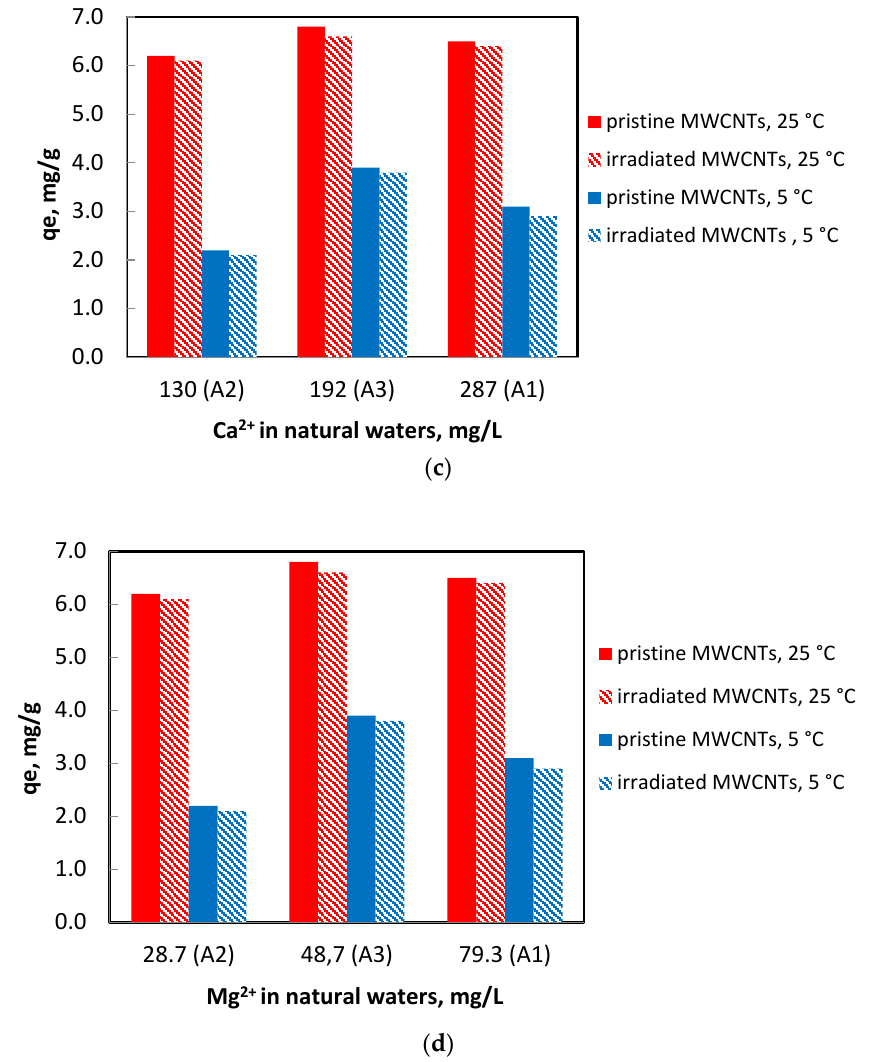
Figure 5. Influence of chemical ionic species (cations) present in tested waters on the adsorption capacity of TCC on MWCNTs at 5 °C and 25 °C: ( a ) Na + , ( b ) K + , ( c ) Ca 2+ , and ( d ) Mg 2+ ; Conditions: Ci = 100 –400 μg/L TCC, m = 0.1 mg MWCNTs, pH A1 = 7.67; pH A2 = 7.33; pH A3 = 8.21; contact time 4 h.